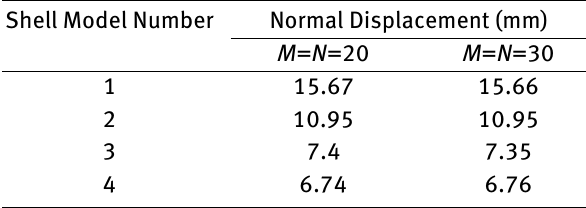
Table 4: Central normal displacement of funicular shell models for two different